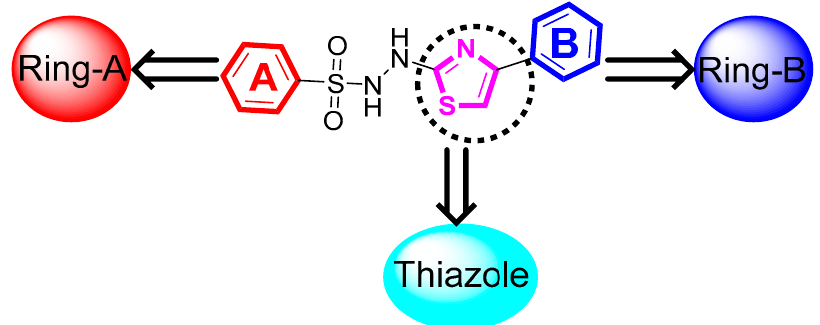
Figure 3. The general structure of thiazole-bearing sulfonamide analogs ( 1 – 21